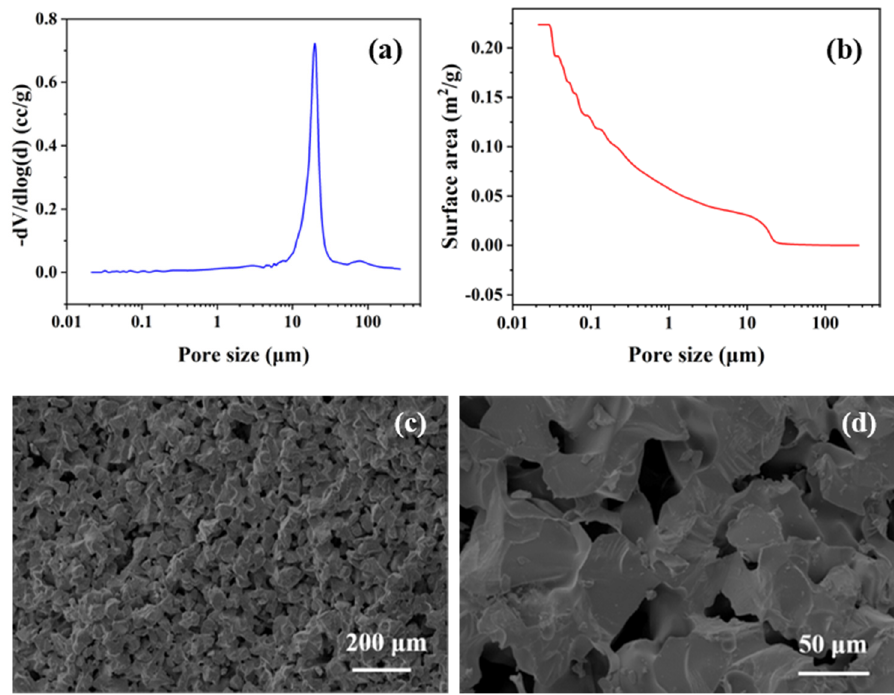
Figure 2. ( a ) Pore size distribution; ( b ) surface area; ( c , d ) fracture surface microstructure of porous SiC ceramic membranes.